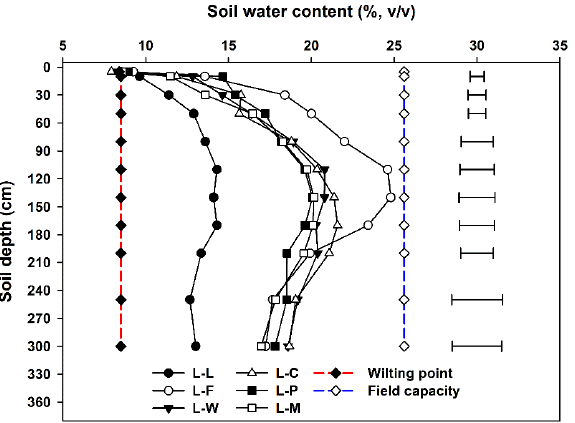
* Treatment abbreviations are defined in Table 1. # Different lowercase letters in the same column represent significant differences at p ≤ 0.05 between treatments. Figure 5. Volumetric soil water content in the 0–300 cm soil depths after lucerne-to-crop conversion in October 2018. Horizontal bars denote Fisher’s protected least significant difference at p ≤ 0.05. Treatment abbreviations are defined in Table 1.